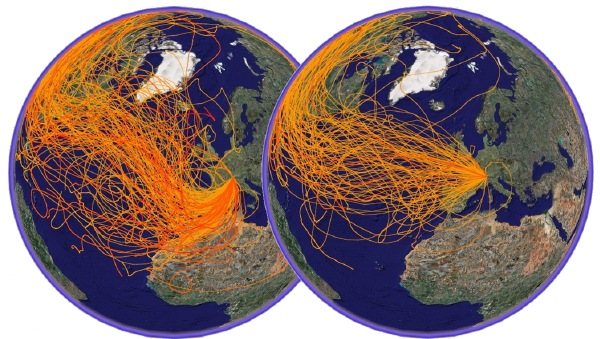
Fig. 5. Isobaric back trajectories at 500hPa of the days with pre- cipitation above 50mm (left) at the Binn and (right) the Mar´ecottes station (source: GoogleEarth).